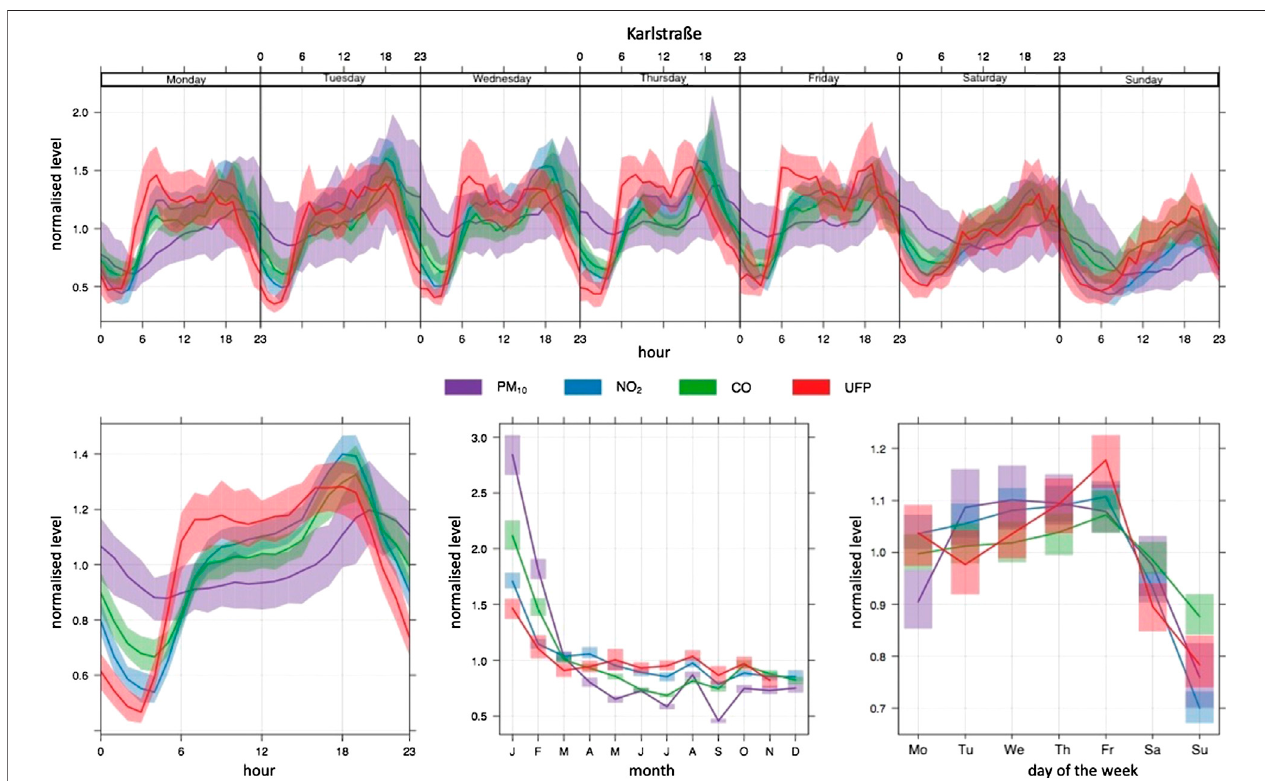
FIGURE 11 | Daily (bottom left), weekly (top: hourly averages, bottom right: daily averages) and annual cycles (bottom center) of the concentrations of PM 10 , NO 2 , CO and UFP at the measurement station in Karlstraße during the measurement campaign 2017 [lines: mean values; shaded areas: fl uctuation range between 5th and 95th